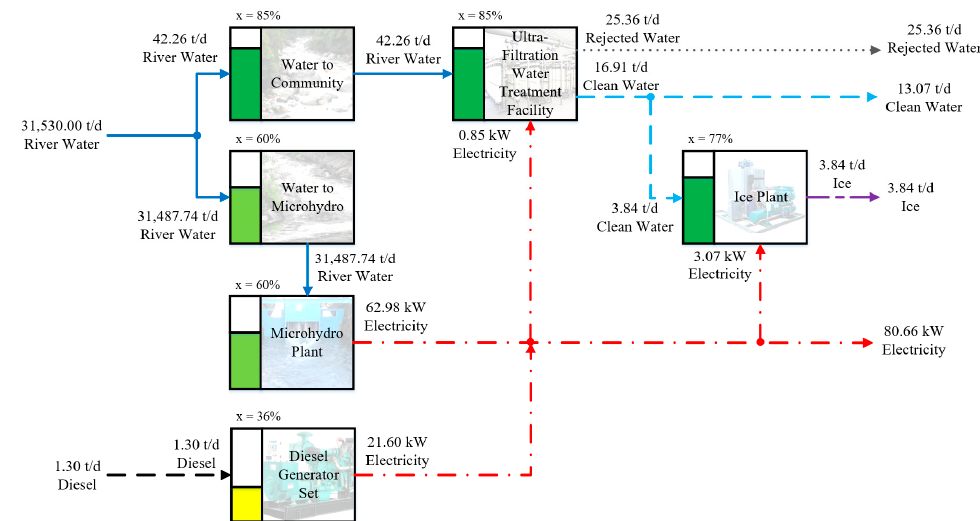
Figure 6. The optimal configuration of the polygeneration system of case study 2 under D = 0.40 (or 40%).